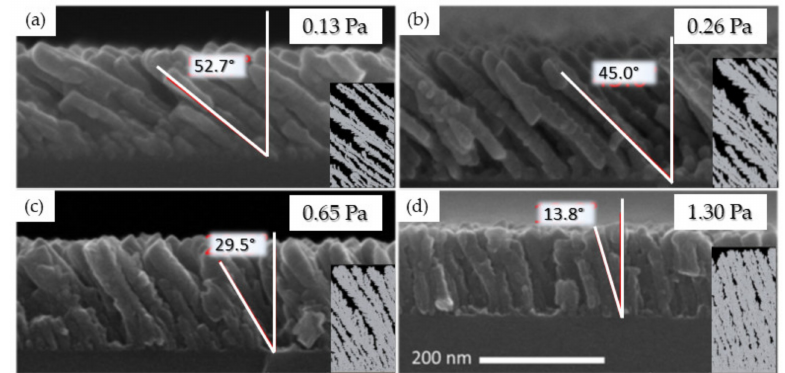
Figure 6. Ti thin films synthesized at 150 W and 85 ◦ for various deposition pressures: ( a ) 0.13; ( b ) 0.26; ( c ) 0.65; ( d ) 1.3 Pa with the corresponding simulations. The red angle accounts for the average columnar tilt angle ( β ) estimated by over 20 columns (adapted from [50] with permission from Elsevier,